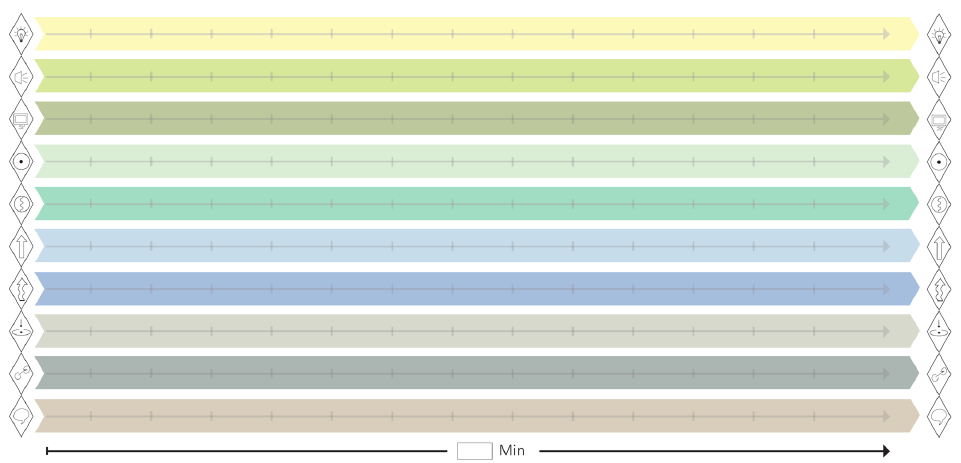
Figure 10. Timeline template to document timing of the different modalities that form the behavioral expression of the